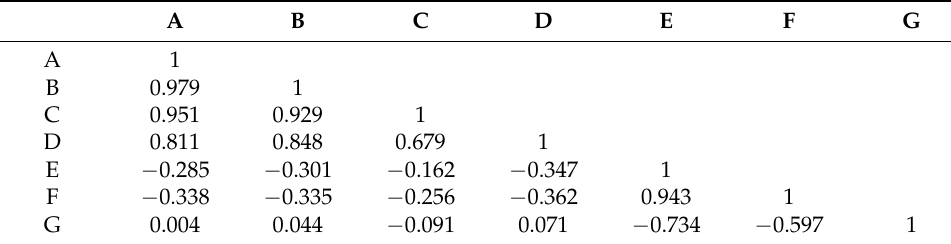
Table 4. Correlation coefficients among the selected parameters. A